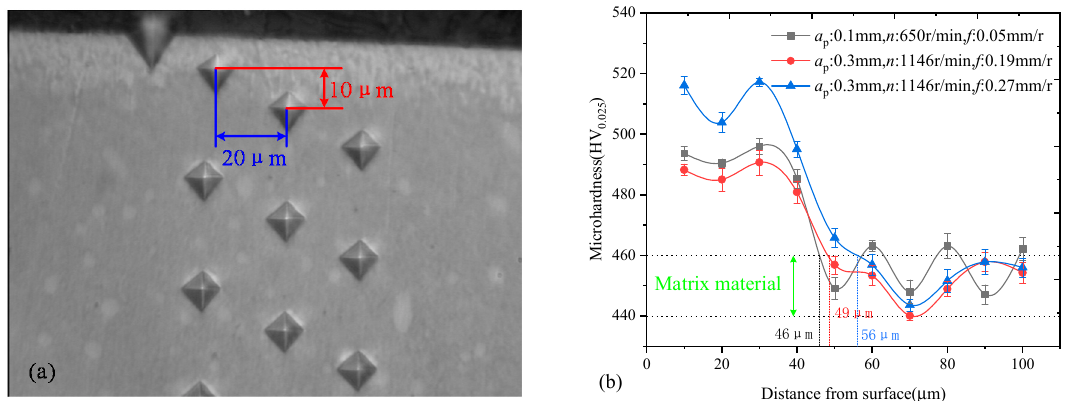
Figure 6. Micro hardness test results of the specimens with different processing parameters ( a ) microhardness distribution test ( b ) microhardness gradient distribution.